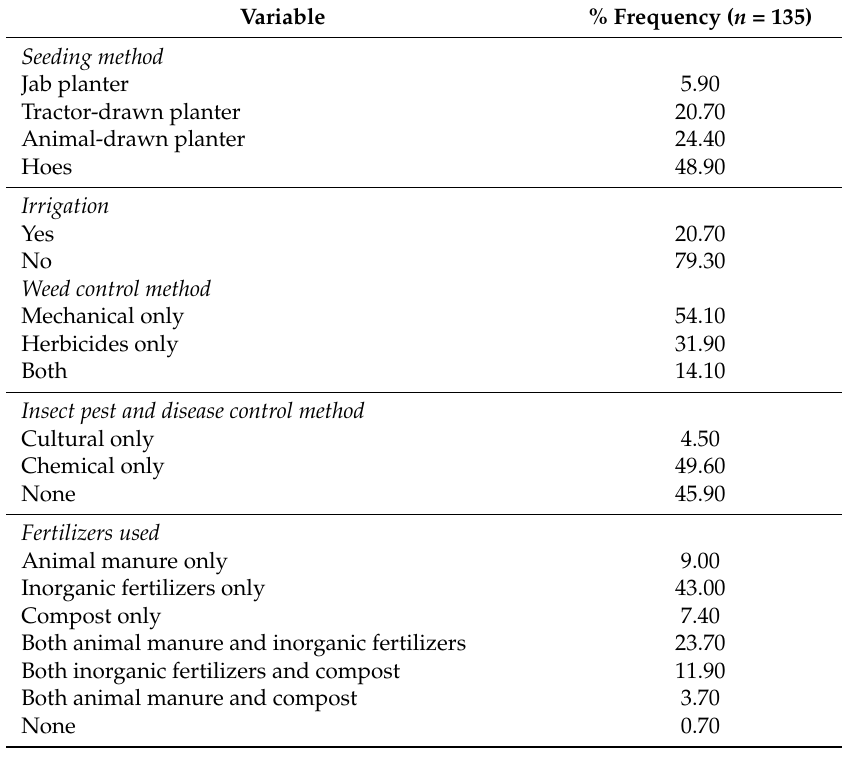
Table 5. Frequencies of common agronomic practices by the sampled smallholder farmers of the Eastern Cape Province.